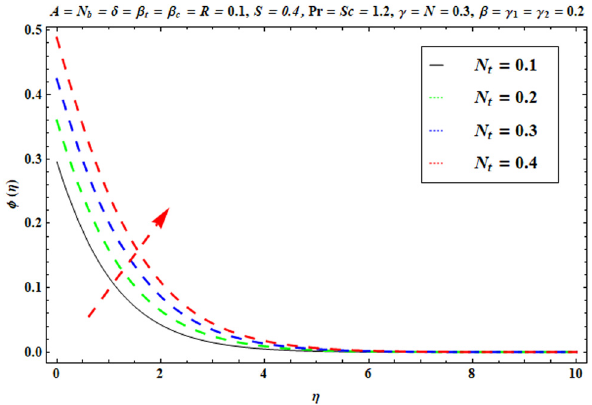
Figure 19: ϕ η ( ) versus N .